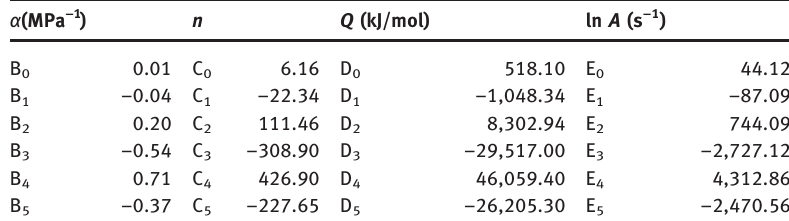
Table 2: The values of α , n , Q , ln A for the studied superalloy.